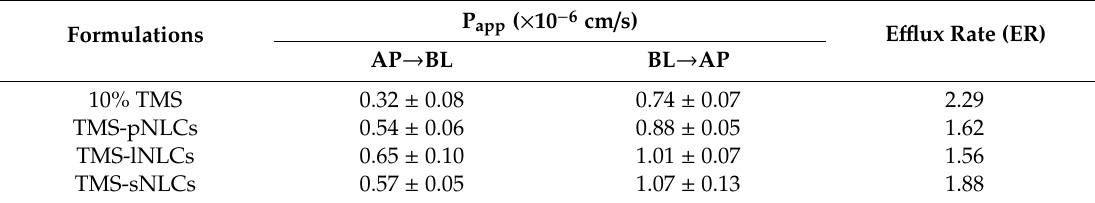
Table 2. Apparent permeability (P app ) and e ffl ux rate (ER) of 10% TMS, TMS-pNLCs, TMS-lNLCs,